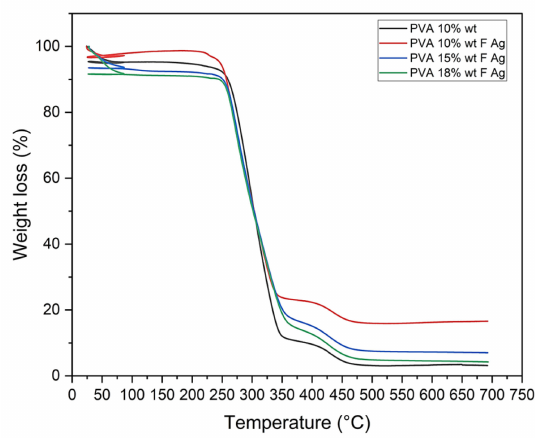
Figure 6. TGA of PVA 10% wt pristine and PVA 10%, 15%, and 18% wt/SF/AgNPs composite